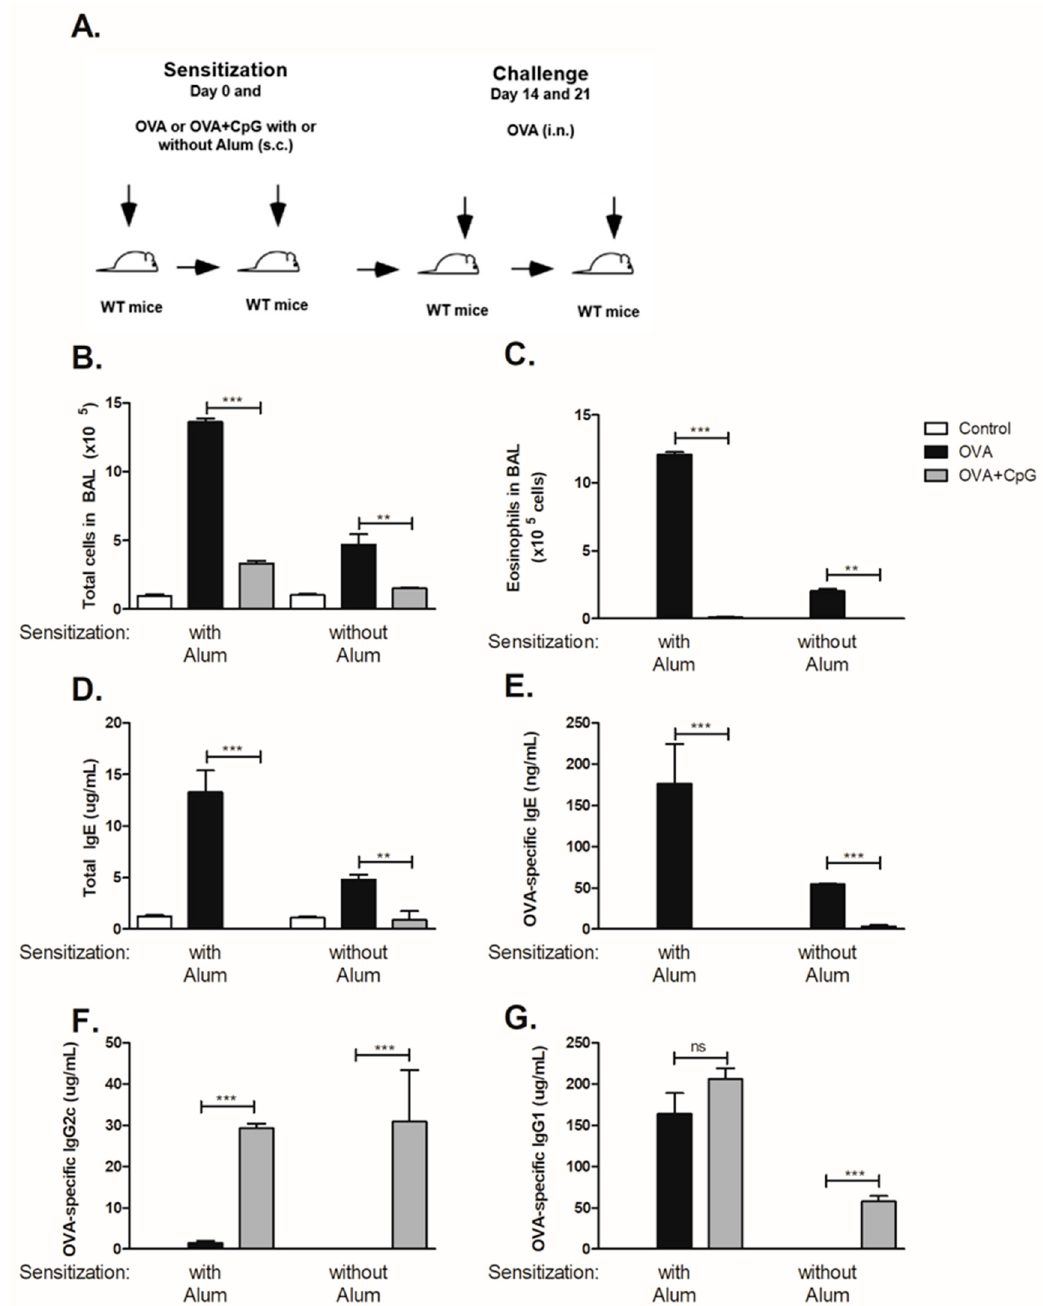
Figure 1. CpG inhibits IgE and enhances IgG production. C57BL / 6 wild-type (WT) mice were subcutaneously sensitized with ovalbumin (OVA) or OVA plus CpG (OVA+CpG) with or without alum adjuvant on days 0 and 7 and challenged intranasally with OVA on days 14 and 21. Experiments were performed on day 22. Control mice consisted of non-manipulated animals. ( A ) Schematic experimental protocols. Numbers of ( B ) Total Cells and ( C ) Eosinophils in BAL. Serum levels of ( D ) Total IgE, ( E ) OVA-specific IgE, ( F ) OVA-specific IgG2c and ( G ) OVA-specific IgG1. Groups sensitized with alum adjuvant ( n = 5) and without alum ( n = 3). Values represent the mean ± SD and are representative of two independent experiments. One-way ANOVA: ** p < 0.01; *** p < 0.001.